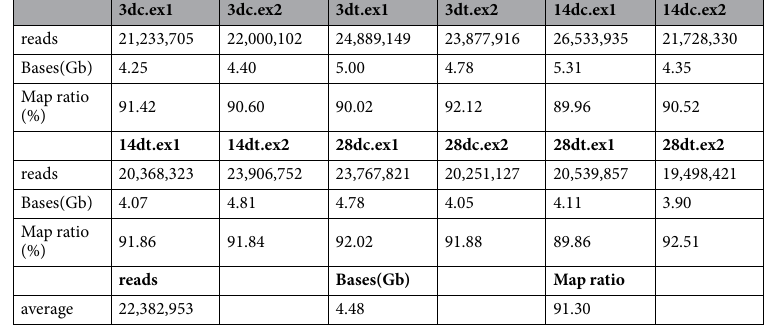
Table 1. The statistics of RNA-seq sequencing data in this study. * Dc and dt represent the control and the treatment in the same time point, respectively; ex1 and ex2 represent two biological replicates.